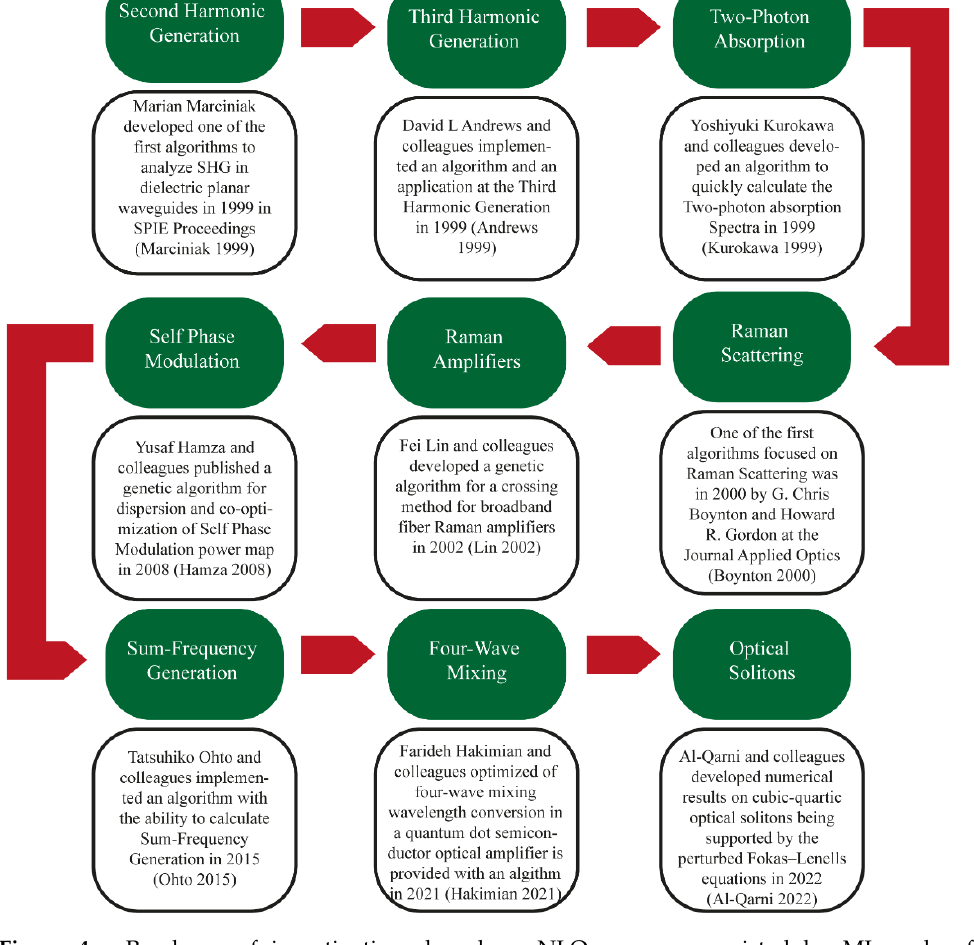
Figure 4. Roadmap of investigations based on NLO processes assisted by ML and soft computing